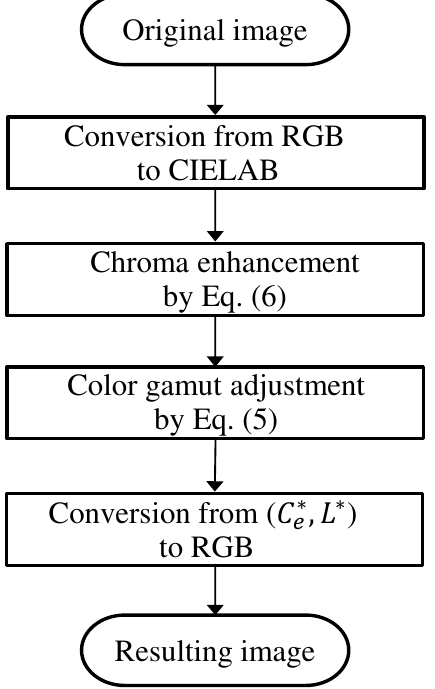
Figure 5. Flow diagram of the proposed